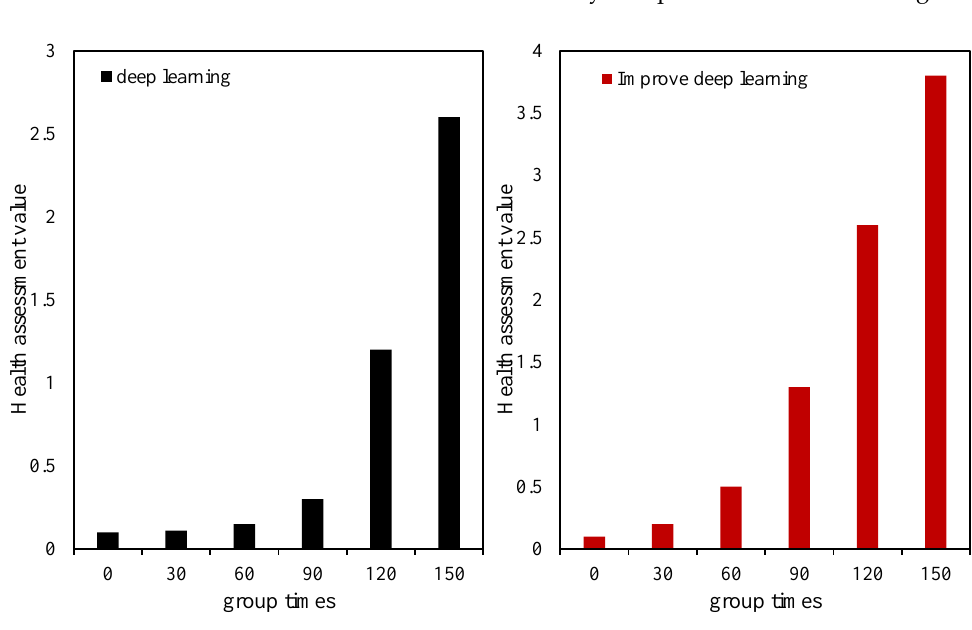
Figure 7. Health index assessment.